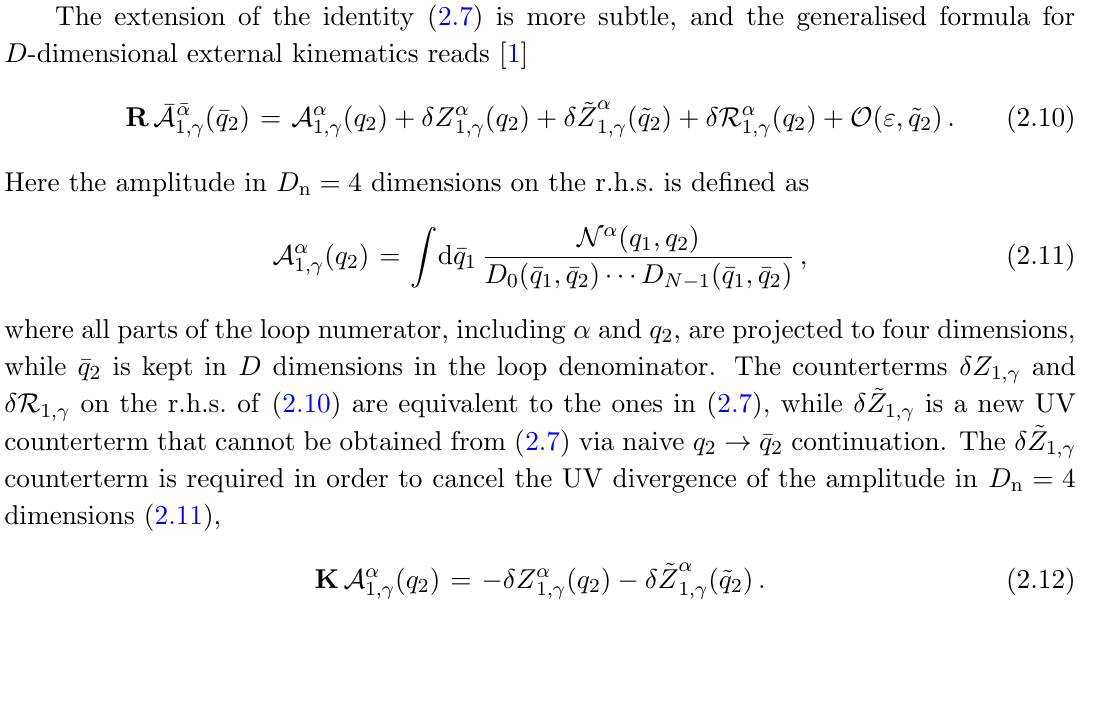
Figure 1 . Examples of UV divergent one-loop subtopologies. The loop momentum (cid:22) q inside the subdiagram, while the two external lines that are going to be embedded in a two-loop diagram depend on the D -dimensional loop momentum (cid:22) q 2 and carry the Lorentz/Dirac indices (cid:22) (cid:11) 1 ; (cid:22) (cid:11) 2